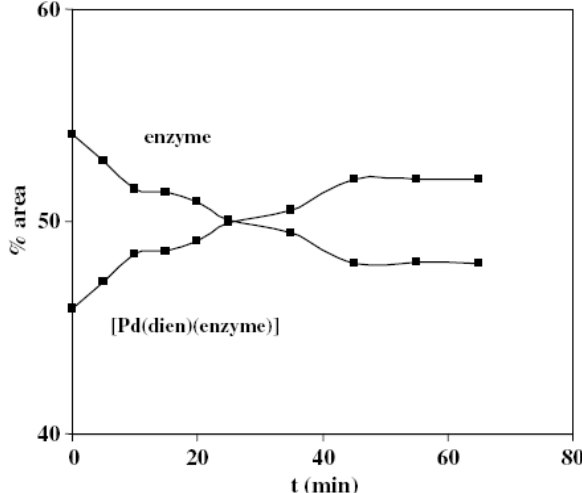
Figure. 6 . Product formation during the reaction of [PdCl(dien)] + with porcine cerebral cortex Na + ,K + -ATPase. Calculations were performed by relative integration (estimated error 5%) of suitable proton signals of reaction product and starting materials during reaction. Reproduced from